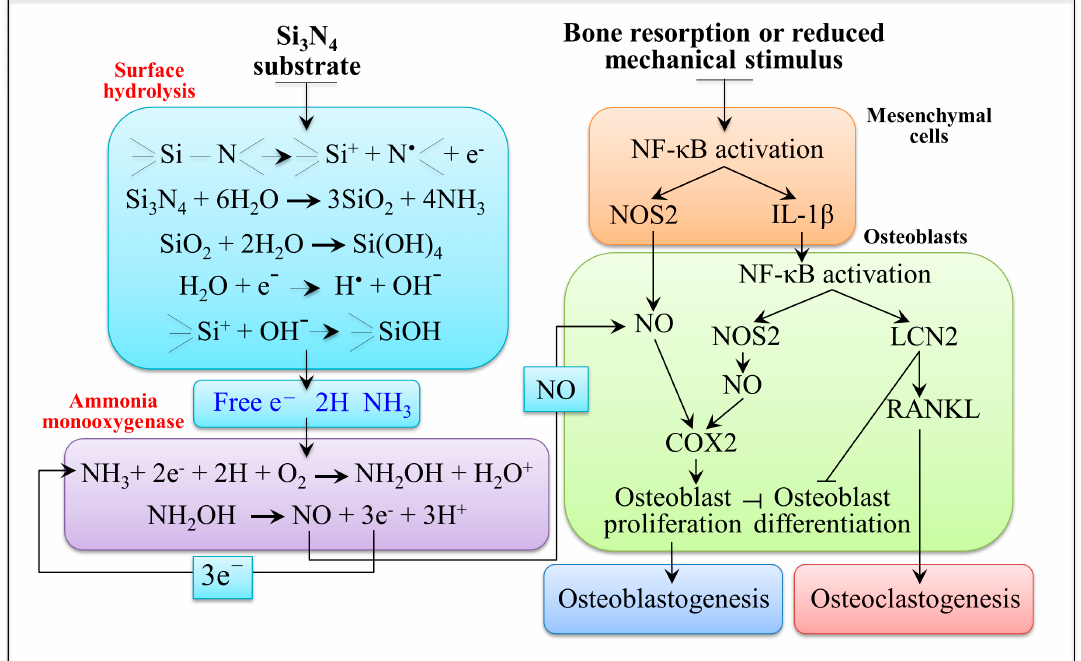
Figure 7. Schematic representation of the pathways involved with osteoblast-osteoclast crosstalk (IL-1 β / LCN2 / RANKL pathway leading to osteoclastogenesis and NOS2 / NO / COX2 pathway leading to osteoblastogenesis); an exogenous NO uplift represents the final e ff ect of RNS formed at the cell / Si 3 N 4 interface as a consequence of hydrolysis and the subsequent cascade of chemical reactions taking place on the Si 3 N 4 substrate in aqueous environment.